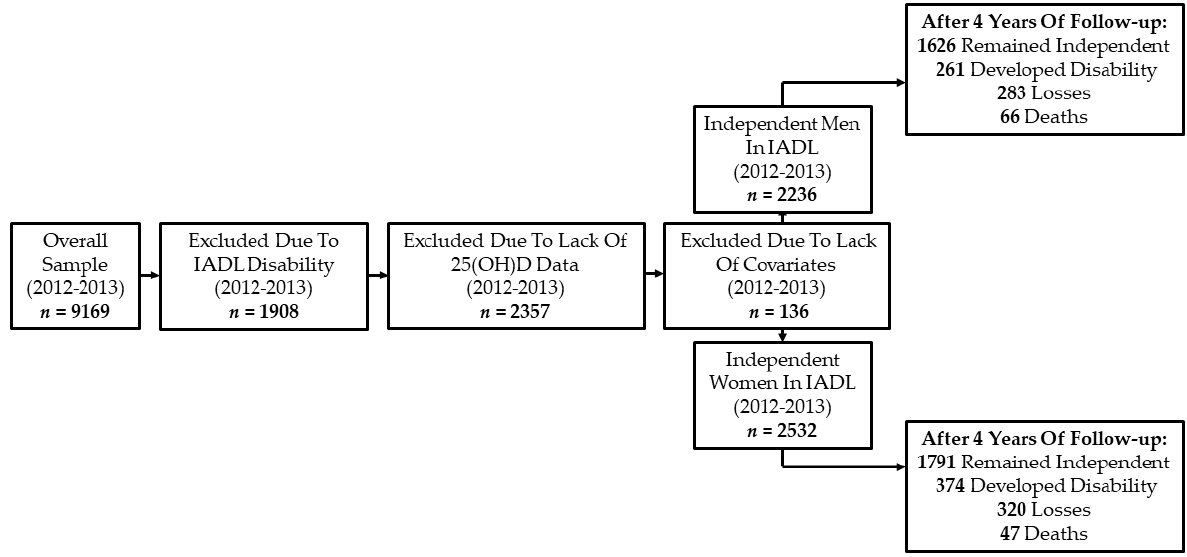
Figure 1. Sample selection flowchart (2012/2013 – 2016/2017). IADL: instrumental activities of daily living; 25(OH)D: 25-hydroxyvitamin D.